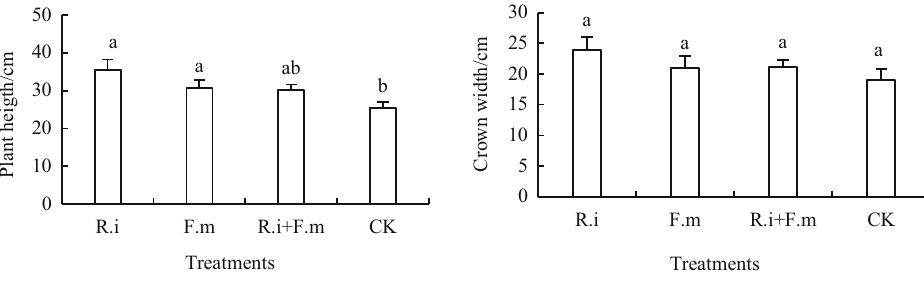
Fig. 1 Effect of AM inoculation on plant height and crown width of Amygdalus pedunculata